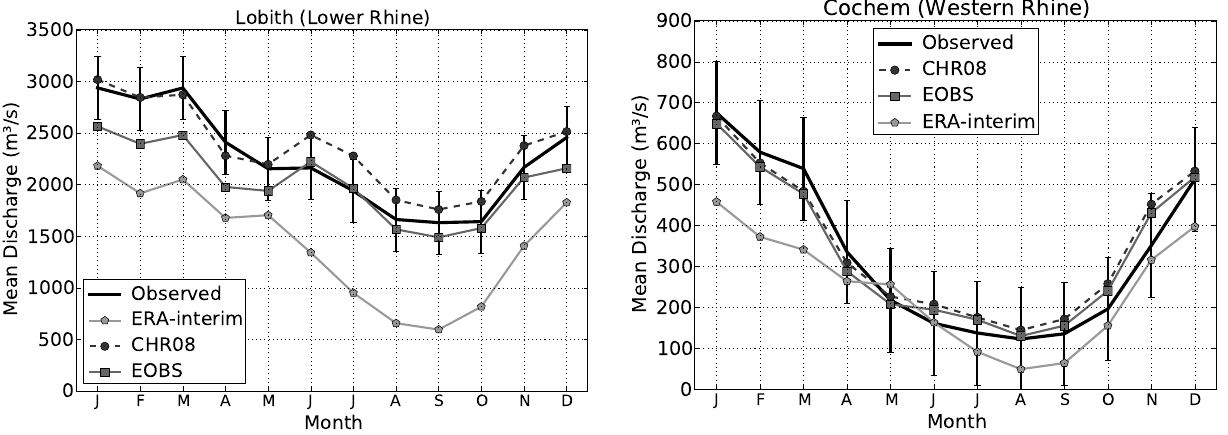
Fig. 4. Mean annual cycle of observed and modeled discharges at Lobith (left panel) and Cochem (right panel) for the period 1990–2008. Also shown are the 95% confidence intervals from the interannual variability of the observed